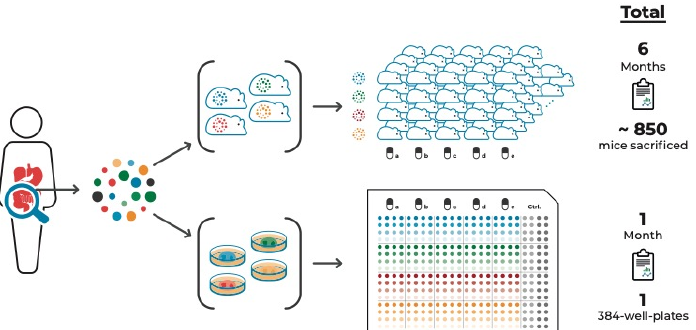
Figure 1. PDO vs. PDX cancer models to study a tumor’s drug response incorporating intra-tumor heterogeneity. Multi-regional sampling of a tumor is required to take ITH into account when assessing the tumor’s drug response. Compared to multi-regional PDX models, multi-regional PDO-based pre-therapeutic drug screenings are significantly more time- and cost-effective. These PDO-based screens, in addition to amplicon sequencing of multiple areas of tumor tissue and derived cell culture models, combined with targeted proteomic approaches, are both feasible and available within a timeframe that allows discussing guided treatment options.